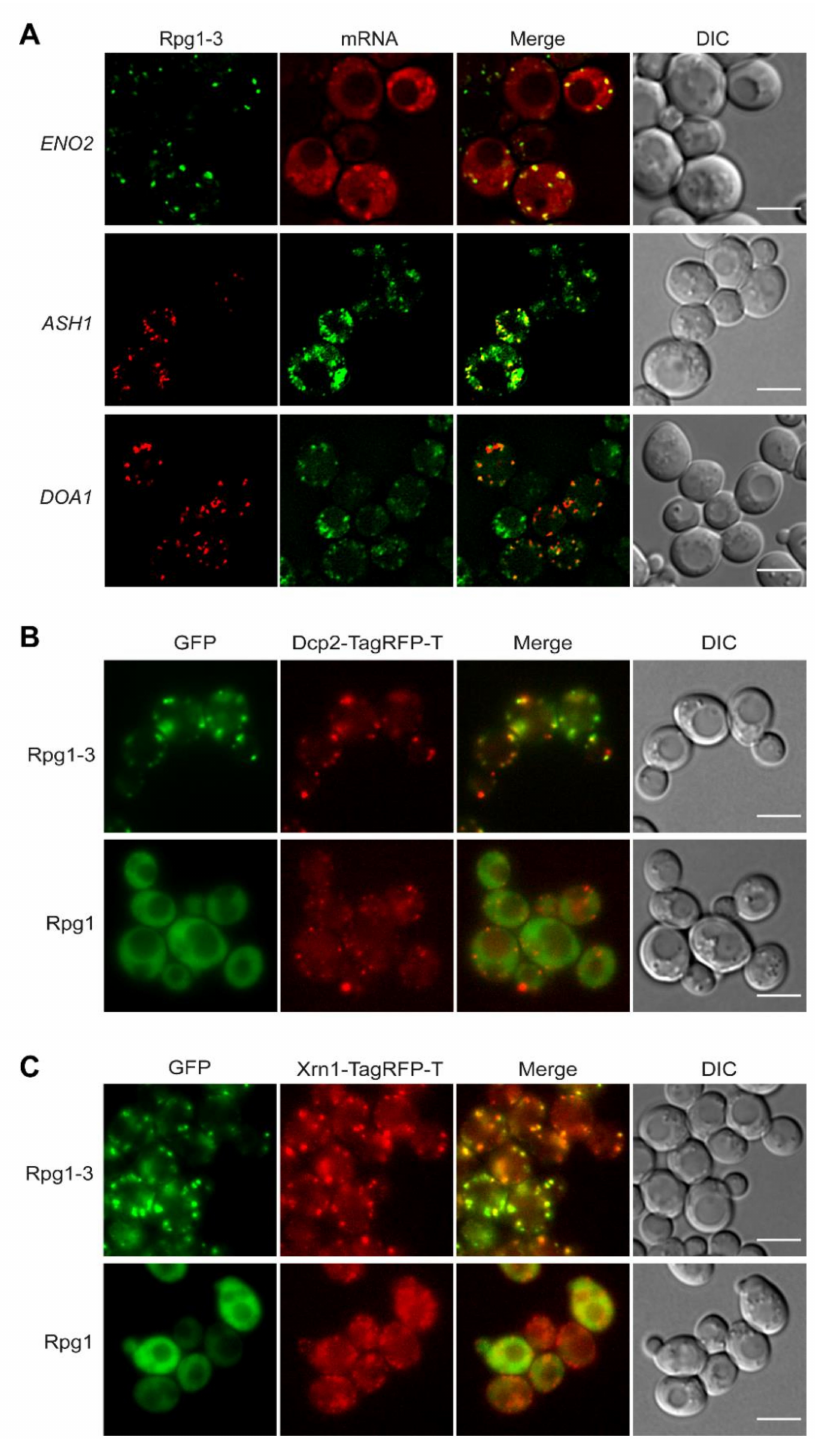
Figure 4. Distribution of mRNAs and P-bodies relative to Rpg1-3. ( A ) Live-cell imaging of ex- ponentially growing cells heat-shocked at 42 ◦ C for 30 min and carrying either Rpg1-3-GFP with ENO2 -mCherry, Rpg1-3-TagRFP-T with ASH1 -GFP, and Rpg1-3-TagRFP-T with DOA1 -GFP. Sin- gle layers of Z-stacks after deconvolution with the AMLE filter (Xcellence software, Olympus) are presented. Association of Rpg1-3 foci with P-body marker proteins ( B ) Dcp2-TagRFP-T or ( C ) Xrn1-TagRFP-T after HS for 30 min at 42 ◦ C. Single layers of Z-stacks are shown. Scale bars, 5 µ